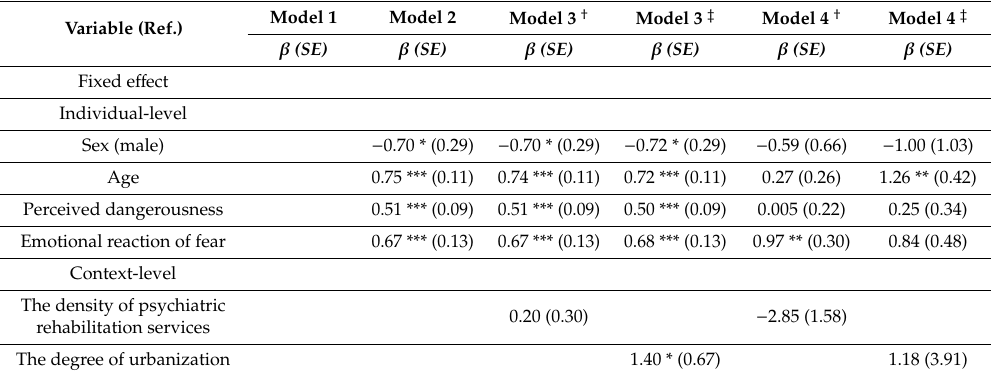
Table 3. Multilevel analysis of individual-level and context-level variables on social distance among general